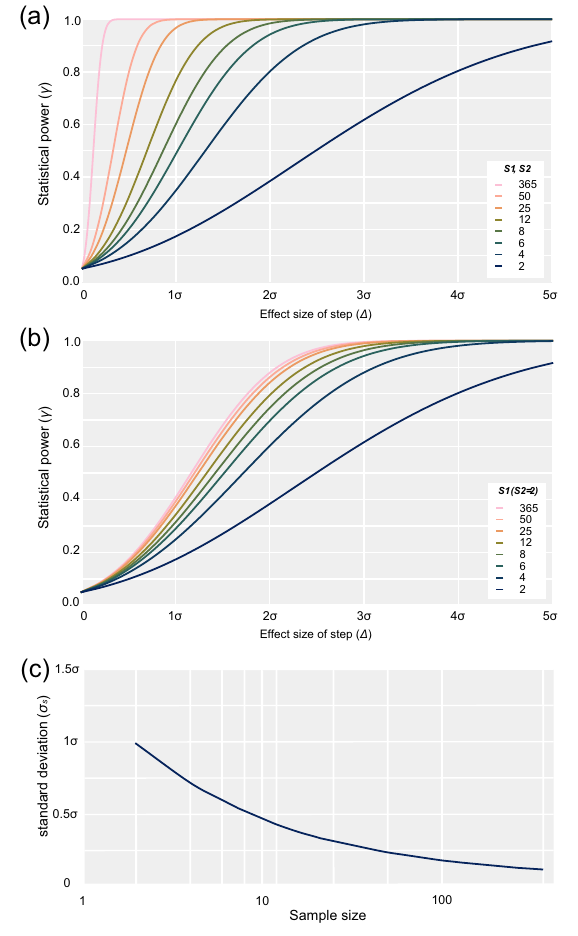
Fig. 3 a Statistical power ( γ ) with respect to effect size ( Δ ) when α 0.05 and one‑sided sample sizes ( S 1 and S 2 in Fig. 1b) are equal. = b γ when S 2 is 2. c Standard deviation ( σ s ) of the detected step with respect to the sample